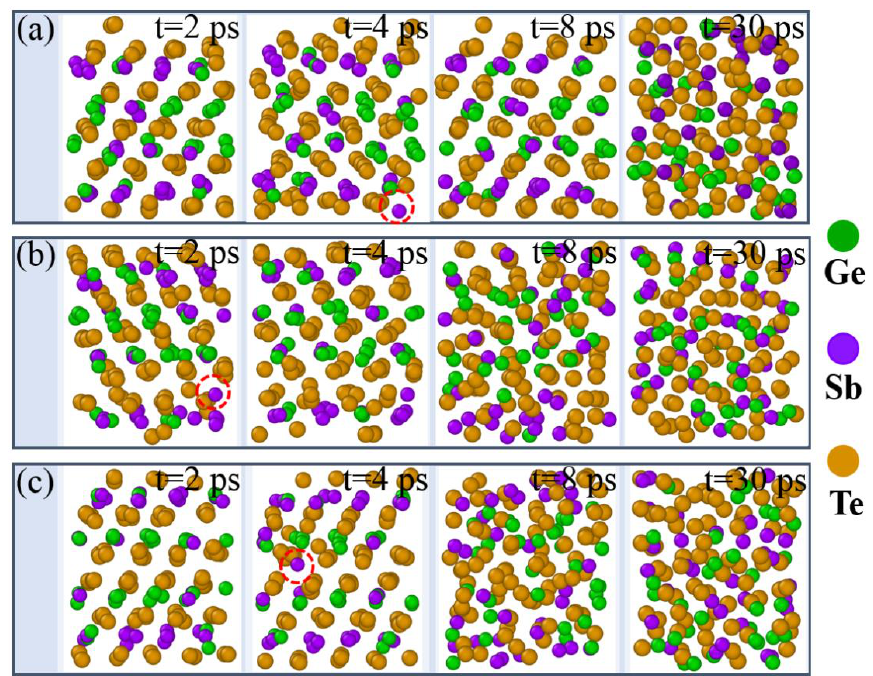
Figure 1. Snapshots of the melting process of GST-SL modes under 1400 K at different times (t = 2, 4, 8, 30 ps). ( a – c ) show the Kooi-mix, Ferro-mix, and Petrov-mix, respectively.